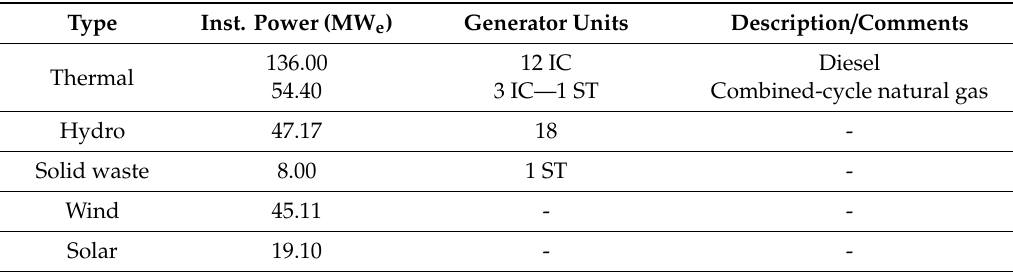
Table 1. Reference case production units’